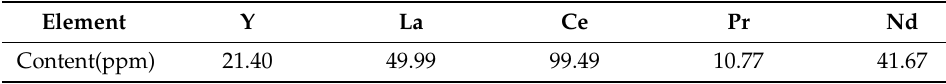
Table 1. Rare earth elements composition of coal fly ash leaching solution.